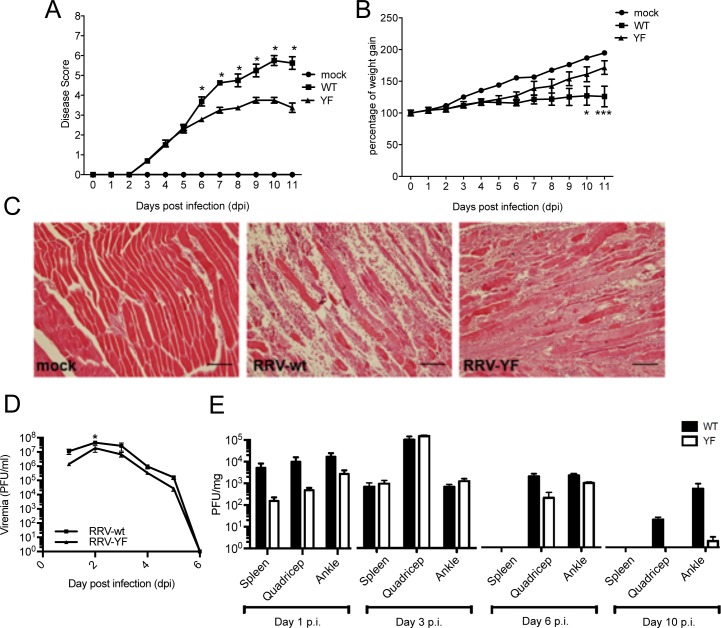
RRV-YF is attenuated in vivo.Disease scores (A) and weights (B) of twenty day old C57BL/6 wt mice injected subcutaneously with 104 pfu of RRV-wt or RRV-YF or mock-infected with PBS. C. Representative histology images (hematoxylin-eosin staining) of quadriceps at 10 days p.i. Scale bar: 100 μm Virus titres from tail blood (D), spleen, quadricep, and ankle (E) at different time points after infection, determined by plaque assay. Data are presented as mean ± SEM of 3–4 mice per group. Statistical significance for the difference between RRV-wt- and RRV-YF-infected mice was determined using two-way ANOVA with Bonferroni post-test (B, D, and E) or non-parametric Mann–Whitney test (A). 0.05> p < 0.01; ** 0.01> p < 0.001; *** p < 0.001.